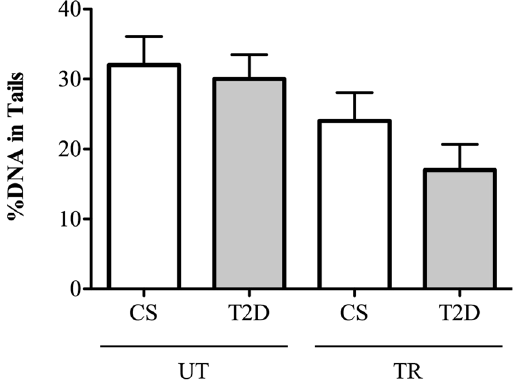
Figure 2. Leukocytes DNA damage in control subjects (CS) and diabetic patients (T2D) of untrained (UT) and trained (TR) groups.